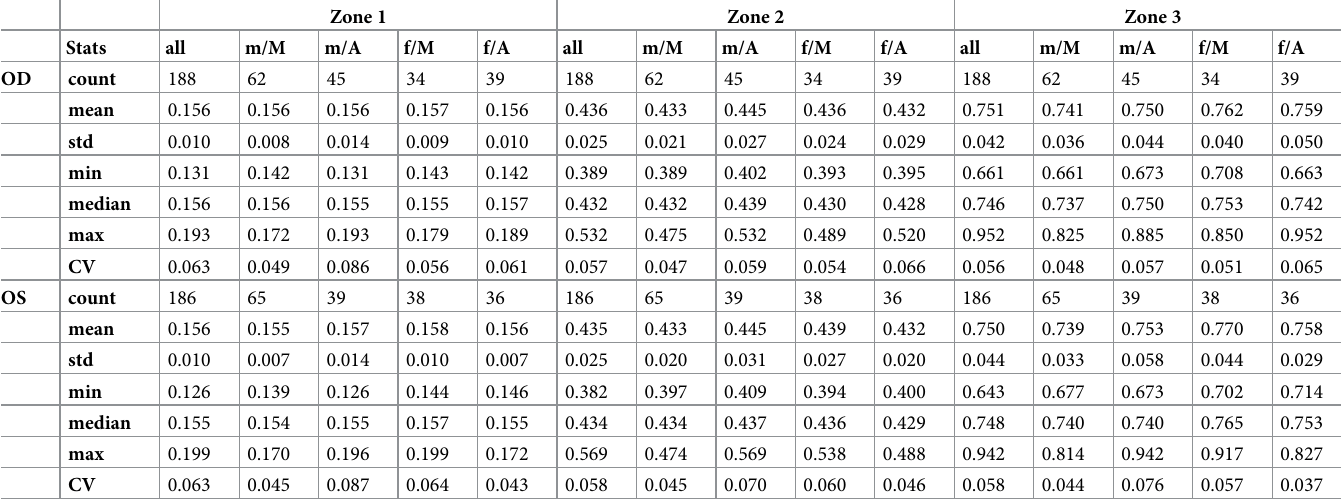
Table 1. Summary presentation of the choroid volume zone values male compared to female monkeys and origin.